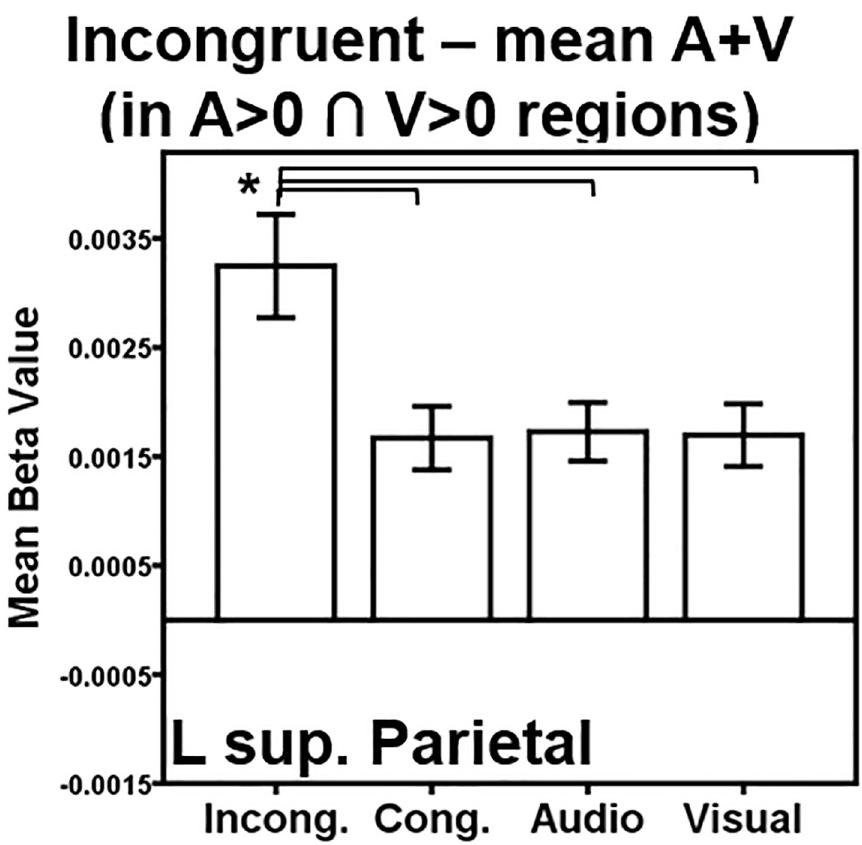
Fig 5. AV incongruent within A > 0 \ V > 0 ROI analysis. A region of interest (ROI) was generated from the significant region of activation in the incongruent > mean of the audio- and visual-only contrast maps within A > 0 \ V > 0 regions in Fig 4. Activation within the ROI is plotted for each condition > rest. Key: L = Left, Sup. = Superior. Conditions: Incong. = Incongruent; Cong. = Congruent; Audio = Audio-only; Visual = Visual-only. Error bars represent ± 1 standard error of the mean. � p < 0.008.